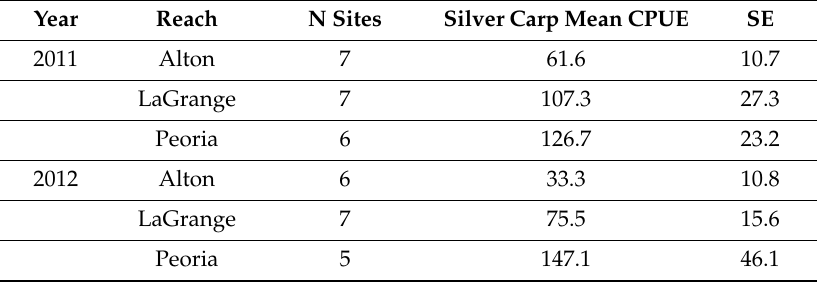
Table 1. Standardized densities (mean fish electrofished per hour; catch per unit e ff ort, CPUE) of silver carp in each reach pool of the Illinois River before (2011) and after (2012) harvesting occurred.